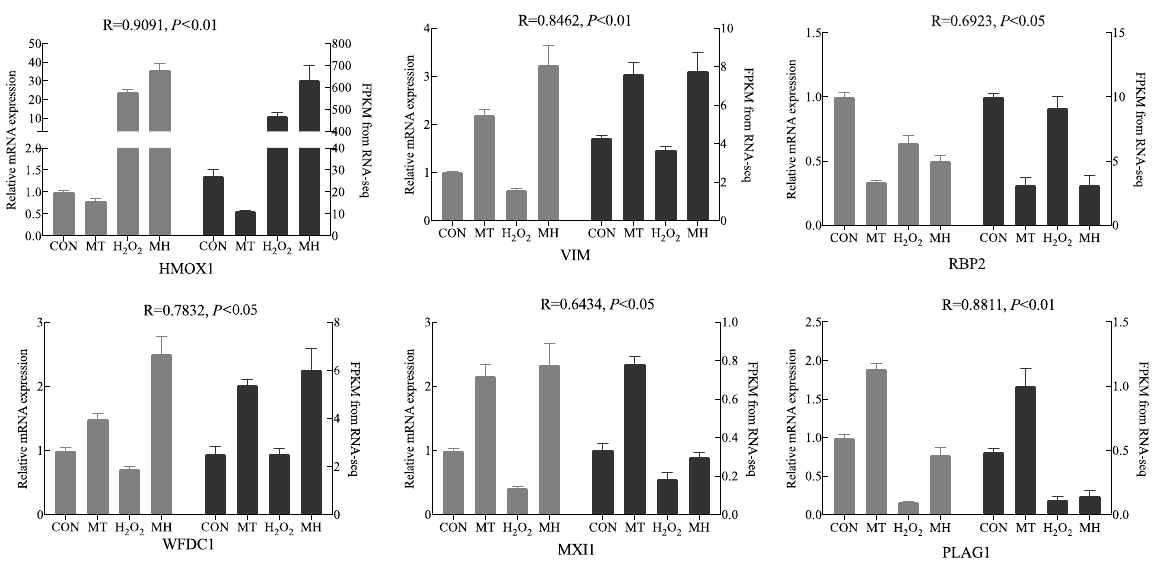
Figure 6. Comparison of the gene expression levels of RNA-seq with real-time PCR. The right axis represents the expression levels determined by RNA-seq in FPKM units, and the left axis represents gene expression levels determined by real-time PCR. Bars represent the mean ± SEM of three samples. The black column indicates the FPKM value; the grey column indicates the real-time PCR using β -actin as a reference gene.